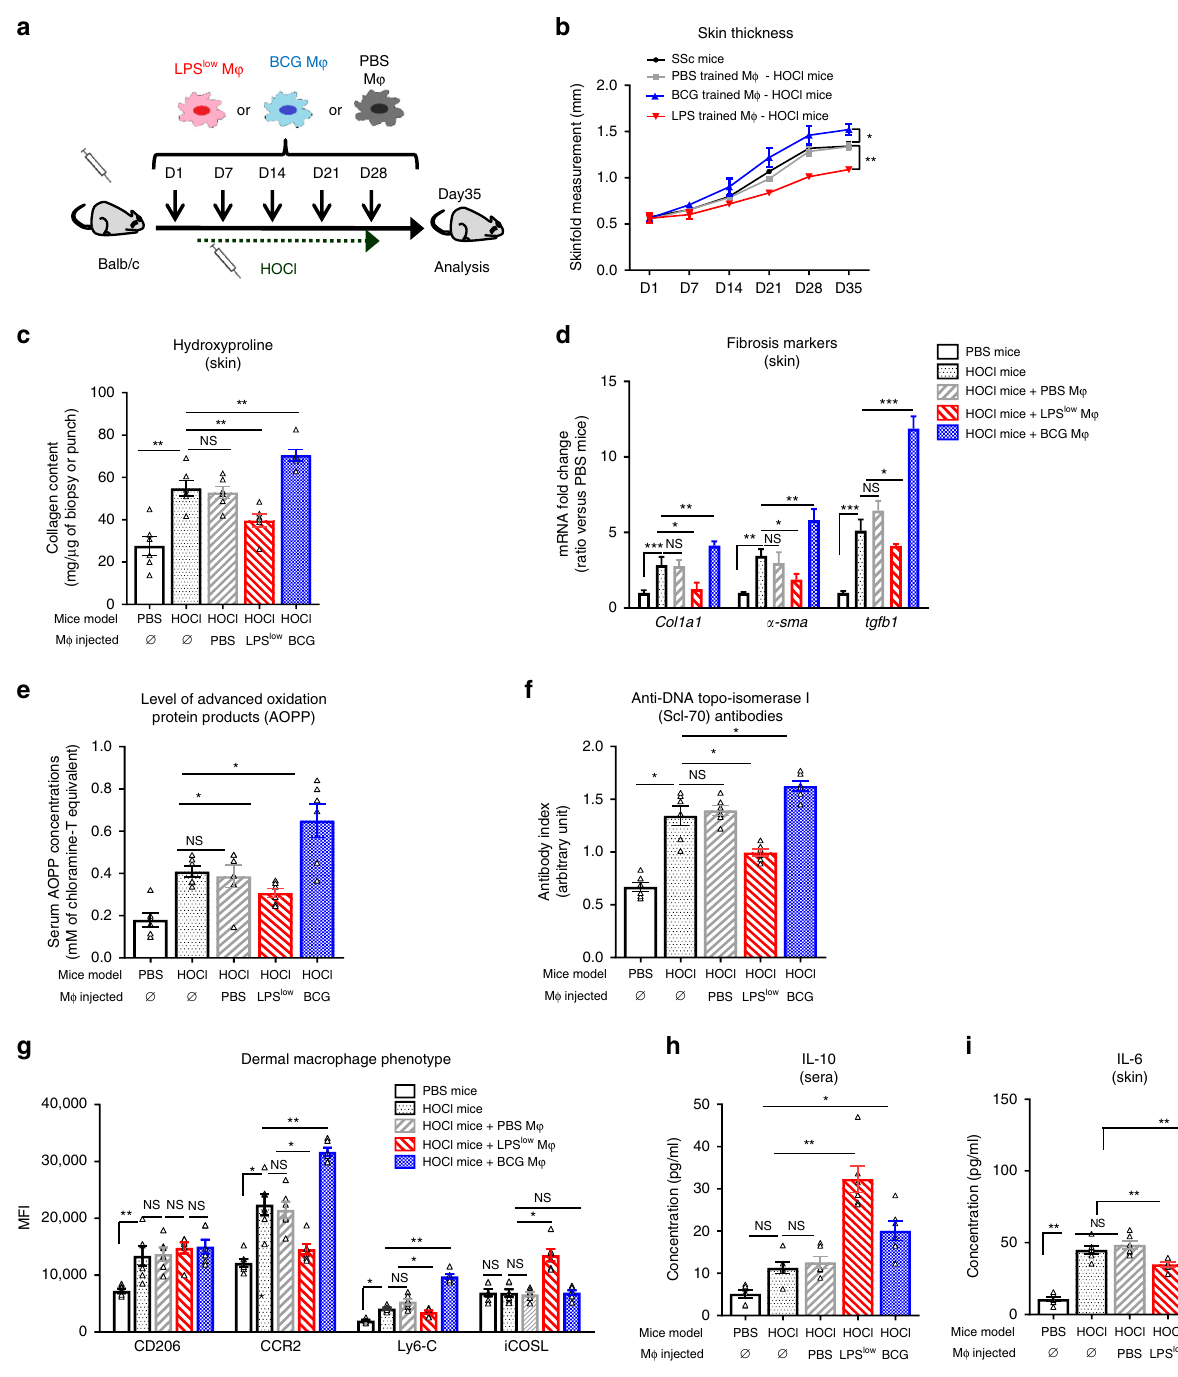
Fig. 5 Adoptive transfer of LPS low trained macrophages ameliorates SSc. a Experimental setup of therapeutic intraperitoneal injection of in vitro trained macrophages to HOCl-mice ( n = 6 in each group). b Evolution of skin fold thickness in millimeters from days 1 to 35, measured weekly. c Collagen content in skin (Hydroxyproline dosage, mg/punch of biopsy). Each box represents mean ± SEM from n = 6 biologically independent mice. d Col1a1 , α -sma , and Tgf- β mRNA levels in skin. Results were expressed as fold increase versus the PBS control group, derived from n = 6 biologically independent mice (Unpaired T -test). e Concentrations of anti-DNA topo-isomerase I (Scl70) antibodies in the sera from mice (Arbitrary Unit). Each box represents mean ± SEM from n = 6 biologically independent mice. f Concentration of advanced oxidation protein products (AOPP) in the sera from mice (mM of chloramine T equivalent). g Flow cytometric analysis of dermal macrophage phenotype at day 35. Dermal cell suspensions were prepared as for the previous experiments. Macrophages were gated on CD11b + F4/80 + cells. Data represent the MFI and SEM from n = 6 biologically independent mice. h , i ELISA assessment of IL-6 production by skin-derived cells ( h ) and seric IL-10 concentration ( i ). Each box represents the mean concentration (pg/ml)± SEM from n = 6 biologically independent mice. Statistics are shown between PBS and HOCl-mice fi rst and then macrophage injected HOCl-mice (PBS, LPS low and BCG) versus un-injected HOCl-mice. The ANOVA test with Bonferroni correction was used to detect signi fi cant differences between the groups (unless stated). M ϕ : Macrophages. NS: Not signi fi cant; * p ≤ 0.05; ** p ≤ 0.01; *** p ≤ 0.001. Source data are provided as a Source Data fi